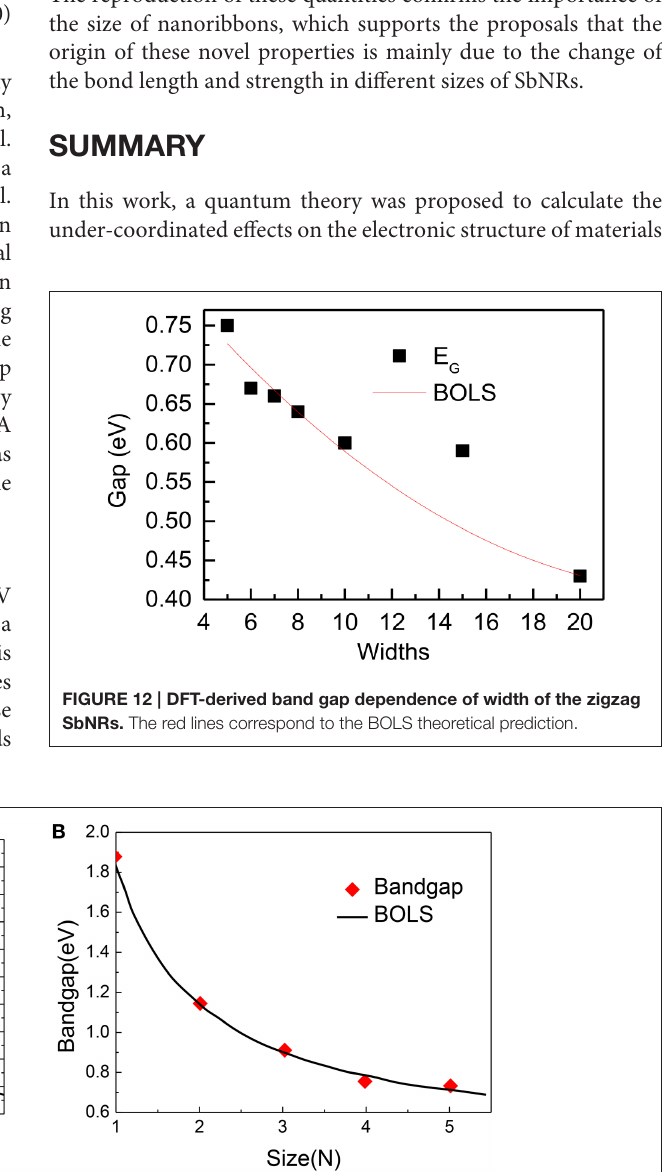
Frontiers in Physics |